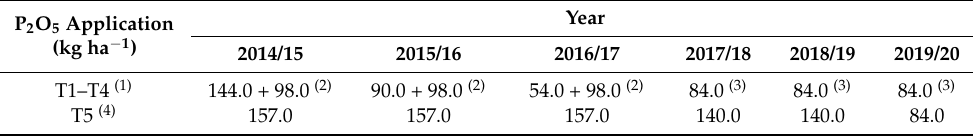
Table 2. Doses of phosphate applied annually during the